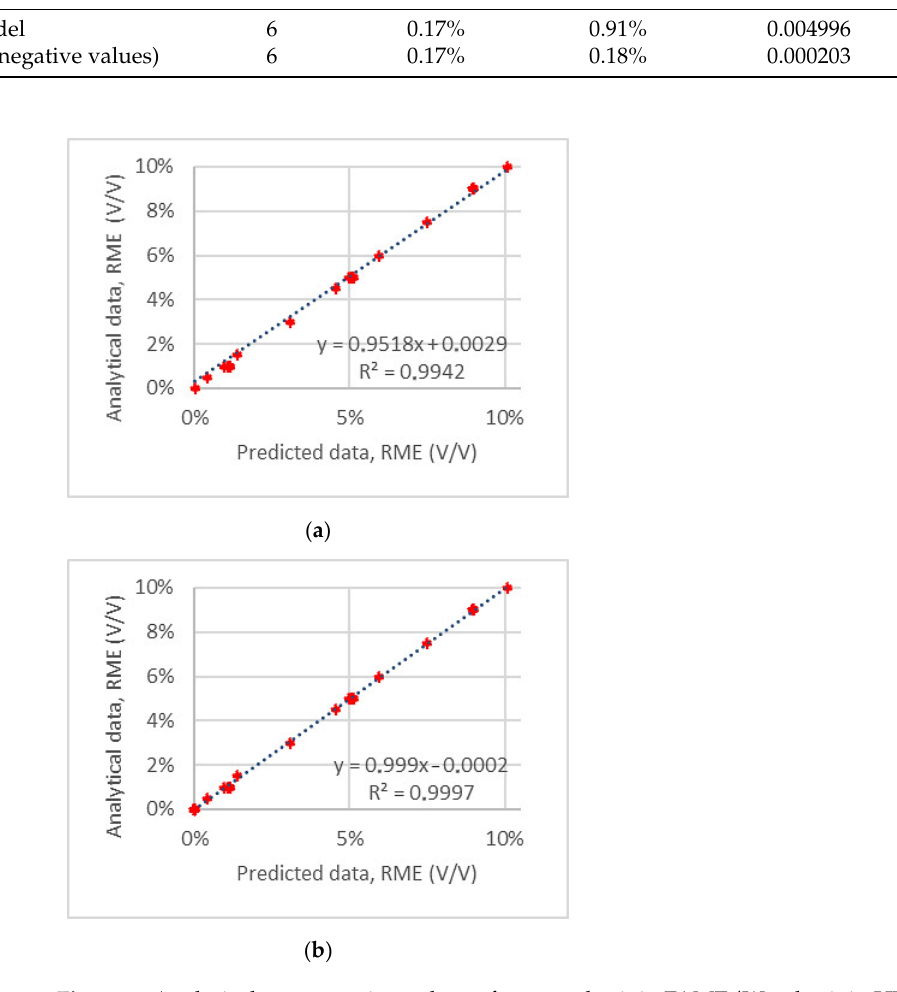
Figure 5. Analytical concentration values of rapeseed origin FAME/Wood origin HVO (Bioverno) diesel blend validation samples versus predicted values using FAME quantification PLS model: ( a )—PLS model predictions, ( b )—PLS model prediction after truncating predicted negative concentrations to zeros.